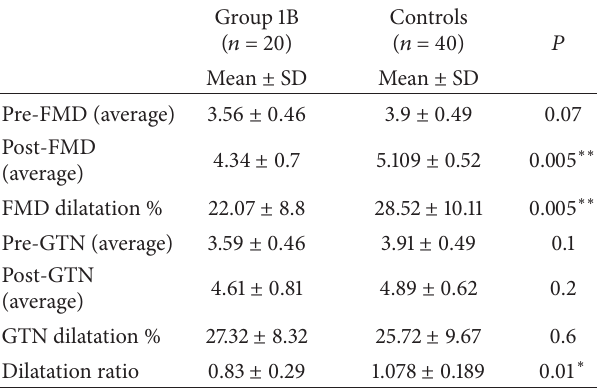
Table 10: Comparison of endothelial function between group 1B and controls.